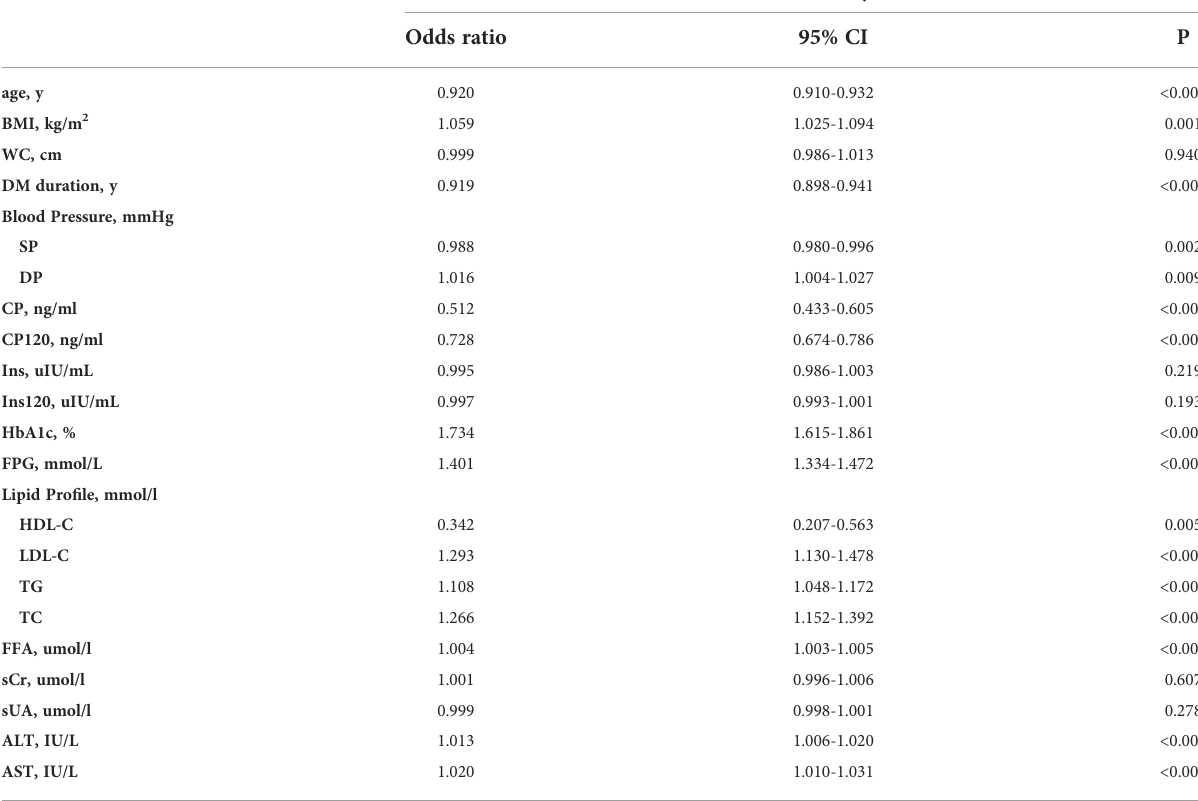
TABLE 2 Univariable logistic regression of patients with and without ketosis in T2DM. Factors